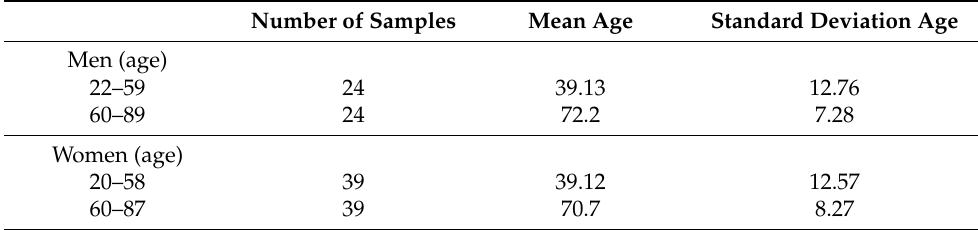
Table 1. Descriptive statistics of voice samples used in the